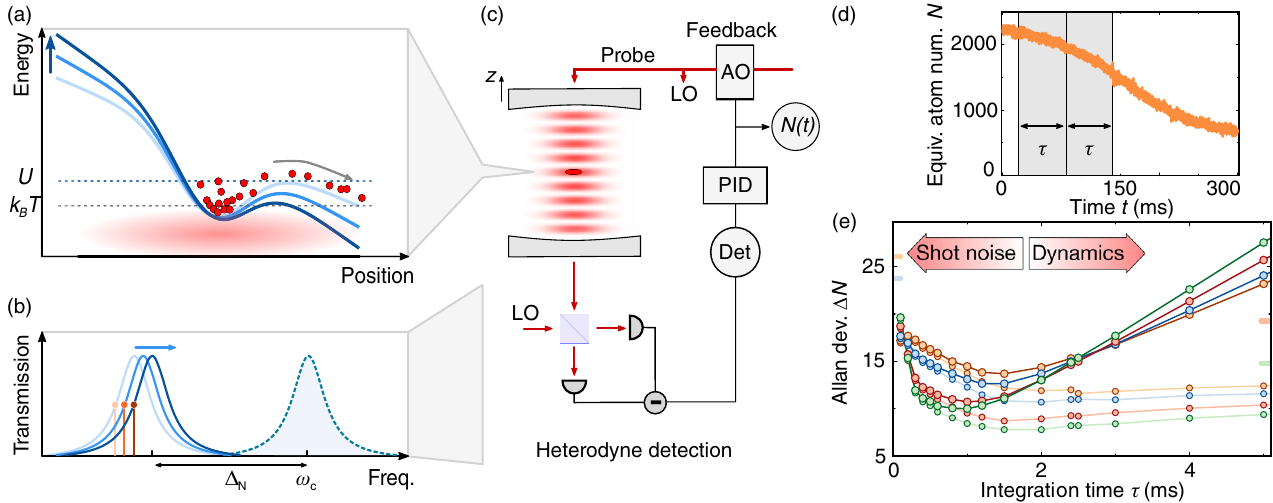
FIG. 1. Experimental setup and measurement imprecision. (a) Schematic of the tilted evaporation of atoms (red) with temperature T in the trap potential (blue) with dynamically lowered depth U . Atoms with energies exceeding the trap depth are spilled. (b) The atoms dispersively couple to the cavity, resulting in an atom-number-dependent shift Δ of the transmission line shape (blue solid traces) N compared to an empty cavity (blue dashed line). Tracking the side of fringe (marked by a red dot and line) provides a dynamical measurement of atom number. (c) The cavity resonance is tracked using a feedback loop involving the cavity-coupled atomic cloud (dark red), located at the intensity maximum of a probe beam in the cavity (light red). The transmitted intensity of probe light is detected using a heterodyne receiver with local oscillator (LO) and a radio-frequency power detector (Det). This power is kept constant using a feedback loop (PID) adjusting the frequency of probe and LO through an acousto-optic modulator (AO). The atom number is derived from an in-loop measurement of the voltage used to adjust a voltage controlled oscillator driving the AO. (d) A single unfiltered trace of equivalent atom number N versus time with the filter procedure indicated (gray shaded areas). (e) The Allan deviation Δ N is dominated by photonic shot noise for small integration times τ and by dynamics of the atom number for large τ . A low-pass filter of the traces with optimal integration time ˜ τ minimizes the noise associated with both effects. The solid lines represent guides to the eye. Larger photon number n [orange, n ¼ 1 . 9 ð 1 Þ ; blue, n ¼ 3 . 2 ð 1 Þ ; red, n ¼ 6 . 0 ð 1 Þ ; green, n ¼ 9 . 7 ð 1 Þ ] results in reduced shot noise but also faster loss of the atoms and, therefore, increased imprecision at longer integration times. The colored ticks mark the noise level set by Poissonian statistics for our lowest measured mean atom number for each n . The light symbols show a reduced Allan deviation, where the average dynamics is subtracted from each trace before calculating Δ N